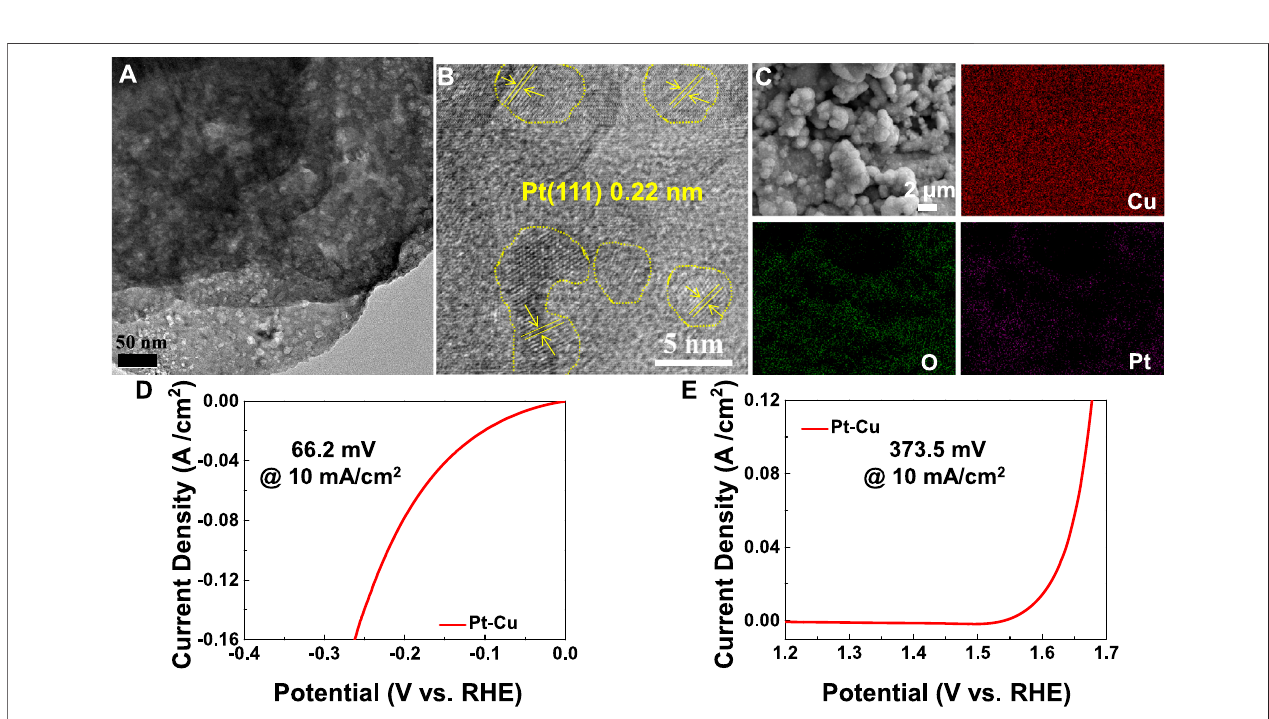
Frontiers in Chemistry |